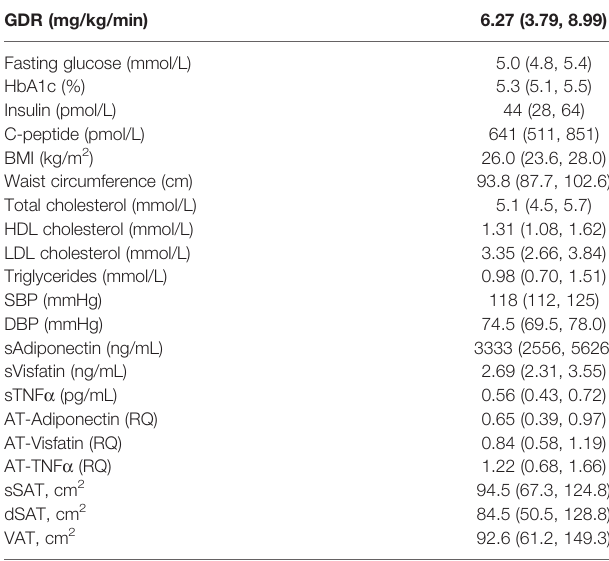
TABLE 1 | Baseline characteristics, circulating levels and gene expression of the adipokines and the amount of AT in the different abdominal compartments of the study population.